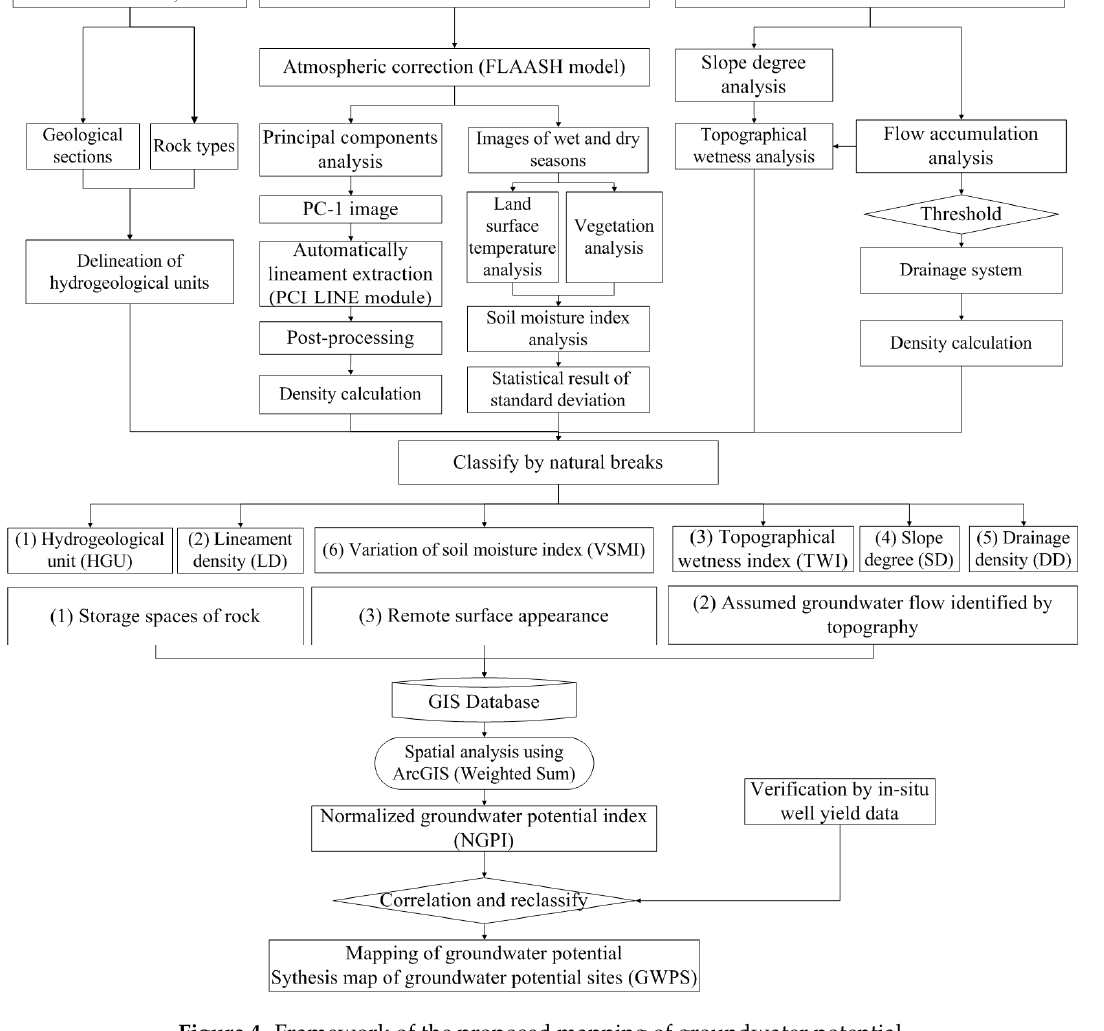
Figure 4. Framework of the proposed mapping of groundwater potential.